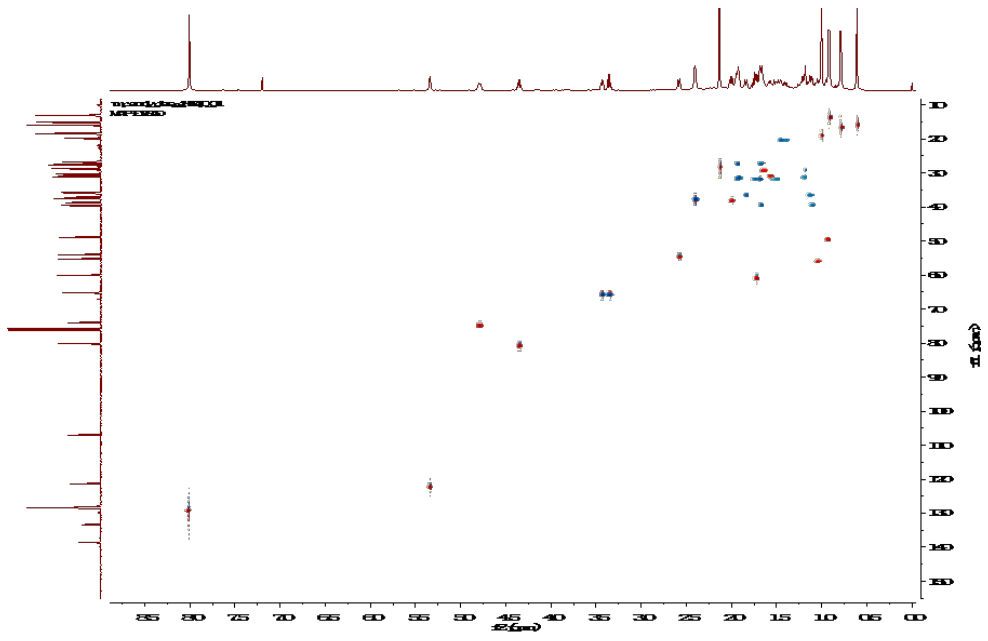
Figure 5. HSQC-NMR experiment at 600 MHz in CDCl 3 of 10a.